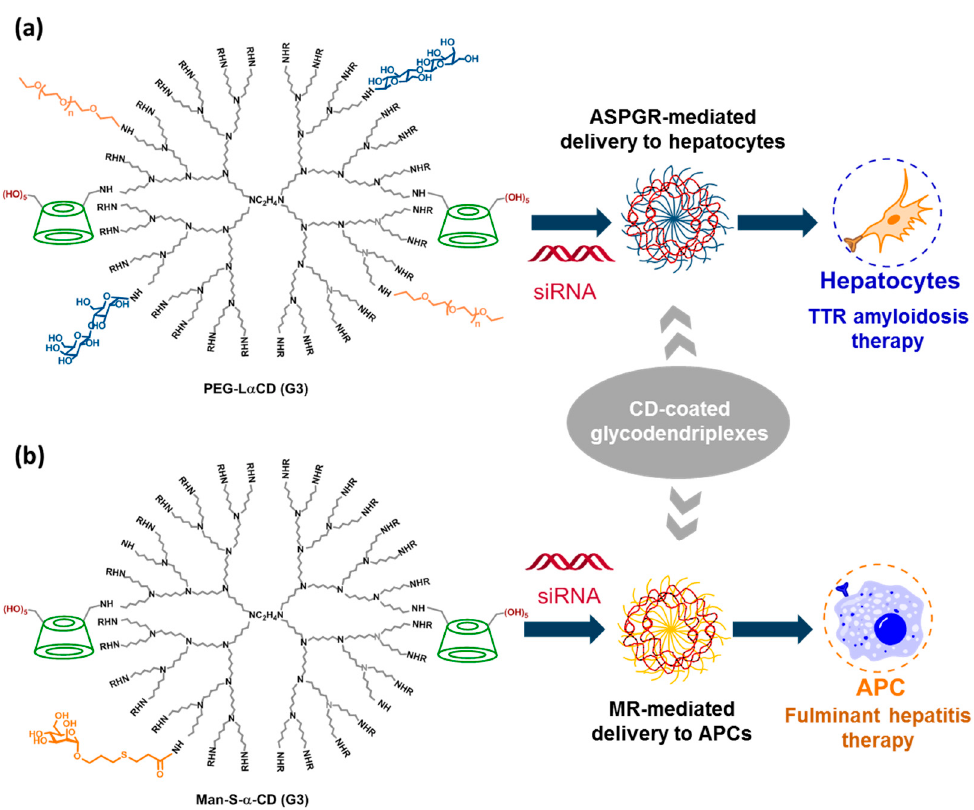
Figure 18. Structures of the lactosylated ( a ) and thiomannosylated ( b ) α CD-coated